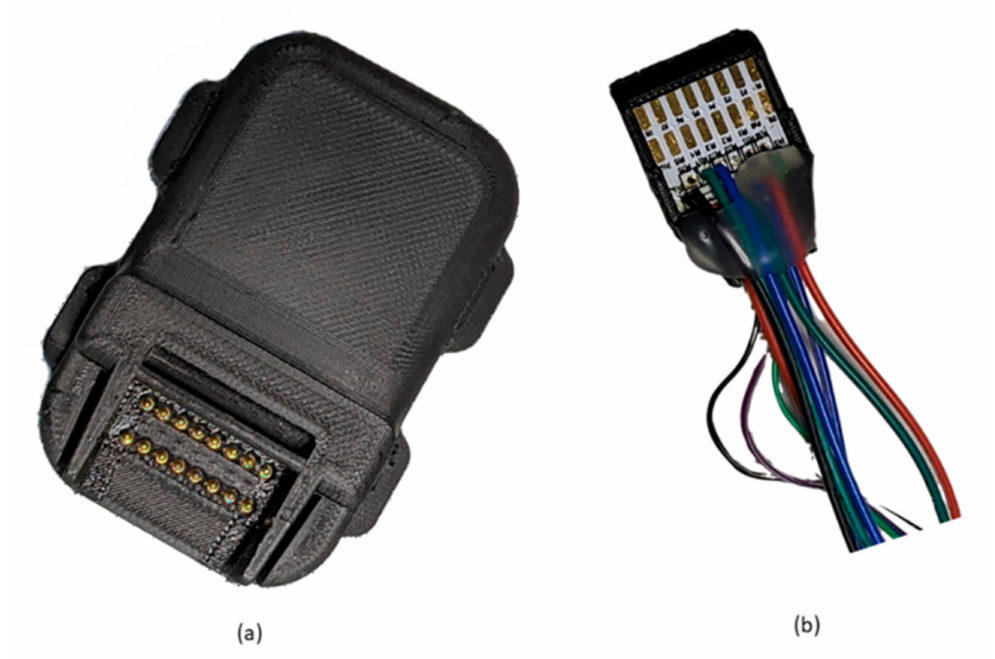
Figure 5. ( a ) enclosed wireless triage box ( b ) wireless triage box connector for the Domed Piezo Sensor, ECG electrodes and Temperature